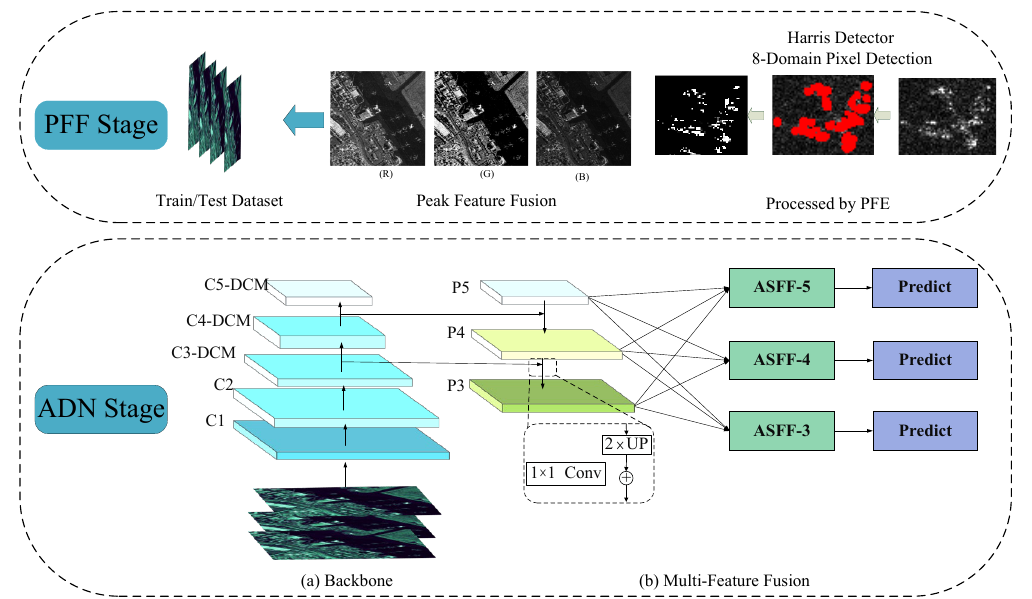
Figure 1. Overview of the PFF-ADN framework. The proposed method mainly comprises the PFF stage and ADN stage. The PFF stage aims to enhance the saliency of the aircraft target in SAR images by fusing the peak features of the aircraft into the image. The ADN is the detection network based on DL, which generates the final detection results.